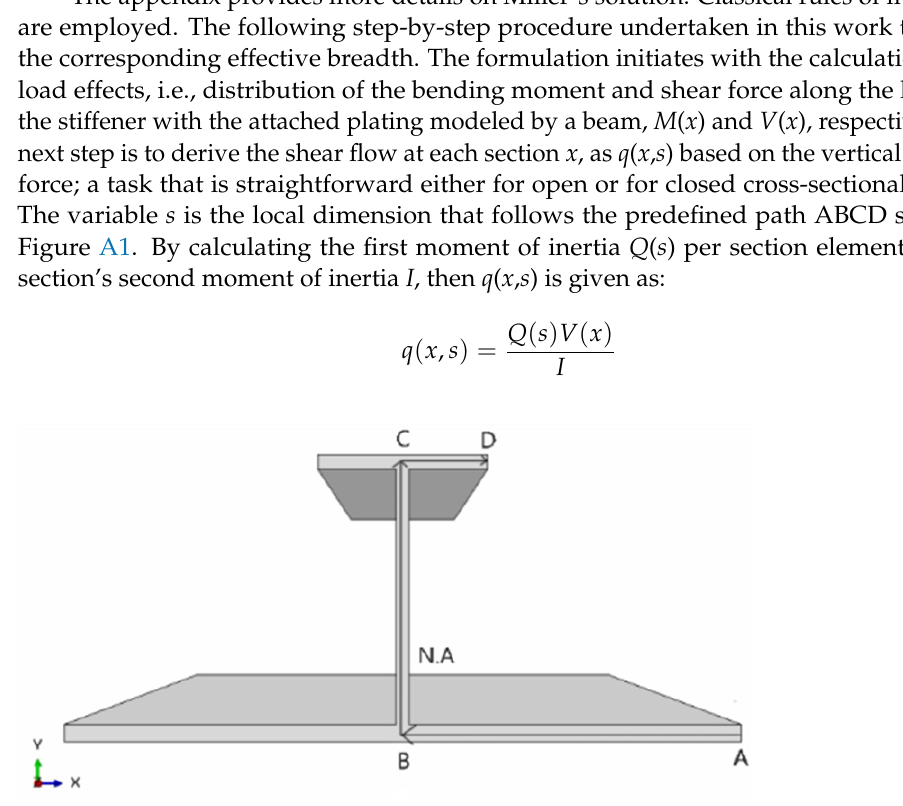
Figure A1. Integration path for shear lag effect calculation.